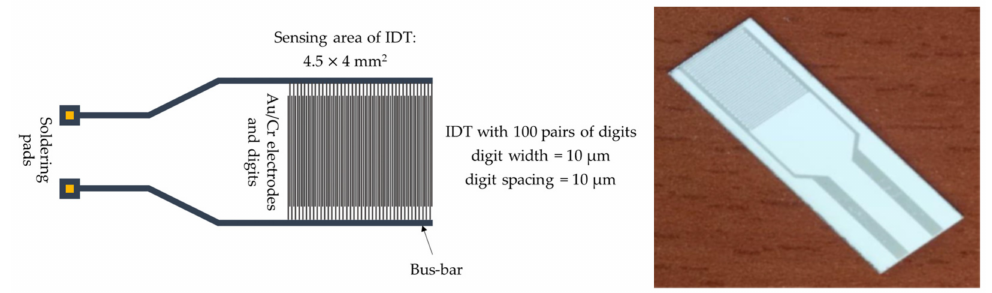
Figure 2. The layout of the (interdigitated) IDT sensing structure.